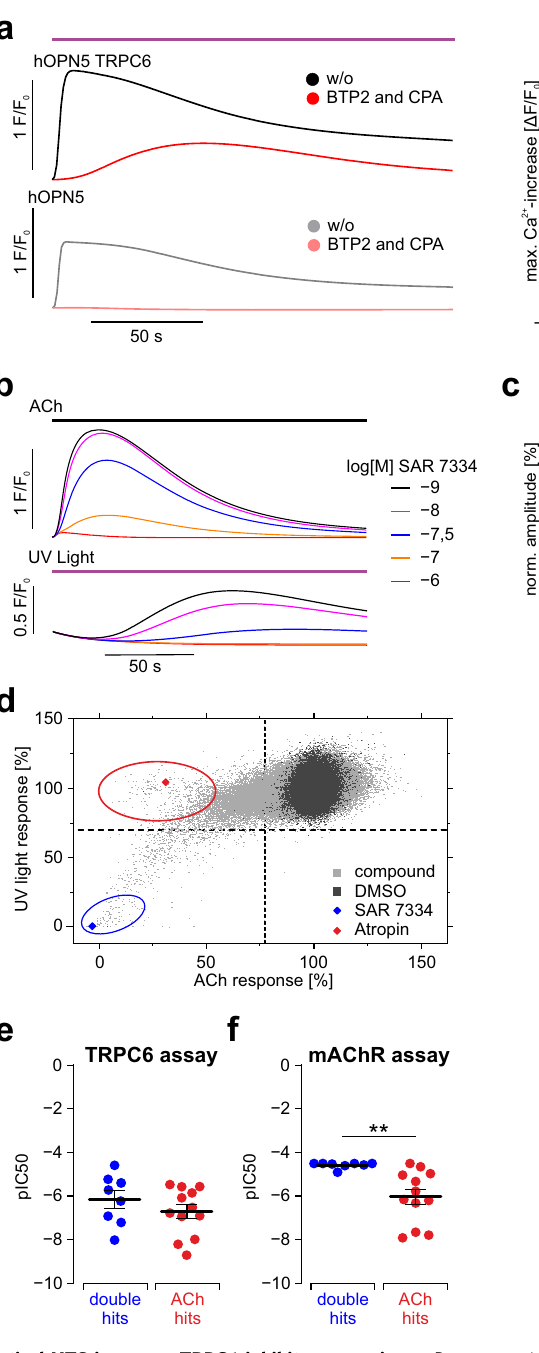
Fig. 4 All-optical HTS improves TRPC6 inhibitor screening. a Representative Fluo-8 Ca 2 + transients (left) and statistical analysis (right) of the maximal Ca 2 + transient amplitudes in hOPN5/TRPC6 HEK cells and hOPN5 HEK cells during UV light stimulation (violet bar, 370nm, 5 µ W/mm 2 ). Ca 2 + release from internal stores was blocked with BTP2 (2 µ M) and CPA (10 µ M) in a subset of experiments (red/light red). Dots represent results from individual wells and statistical analysis was performed with ordinary one-way ANOVA test with Tukey ’ s multiple comparison post-test (all p -values<0.0001). b , c Dose response- analysis of TRPC6 blocking effect of SAR 7334 for ACh mediated (100 µ M) and UV light-induced (24 µ W/mm 2 ) Ca 2 + transients. Representative UV light and ACh-induced Ca 2 + transients under BTP2 and CPA (average of a quadruplicate) in the presence of different concentrations of SAR 7334 (b). Dose response- analysis of the TRPC6 blocking effect with a Hill fi t for ACh (red fi t, black dots) and for UV light-induced (violet fi t, gray dots) Ca 2 + transients ( c , N = 4). d Normalized effects of 218,064 test compounds (left, gray, at 6 µ M) in the HTS on TRPC6-dependent Ca 2 + transients induced by ACh or UV light with DMSO controls (black), atropine (red diamond, 6 µ M) and SAR 7334 (blue diamond, 3 µ M). d Comparison (right) of primary hits, “ frequent hitter ” and PAINS (right) found only in the all-optical HTS (black), only in ACh HTS (ACh hits, red) or in both screens (double hits, blue). e , f Validation of compounds identi fi ed in the HTS from d , lower left quadrant (blue circle around double hits) and d upper left quadrant (red circle around ACh hits) using ACh stimulation in an TRPC6 assay with TRPC6 cells and BTP2 and CPA supplementation ( e , p = 0.29) and in an mAChR assay in HEK wild-type cells with intact Ca 2 + store release ( f , p = 0.004). In e , f one dot represents the average half maximal effective concentration (pIC50) of one substance (tested at least eight times). Unpaired, two-sided Student ’ s t test. Data are presented as mean values ±SEM. ** p < 0.01; *** p <